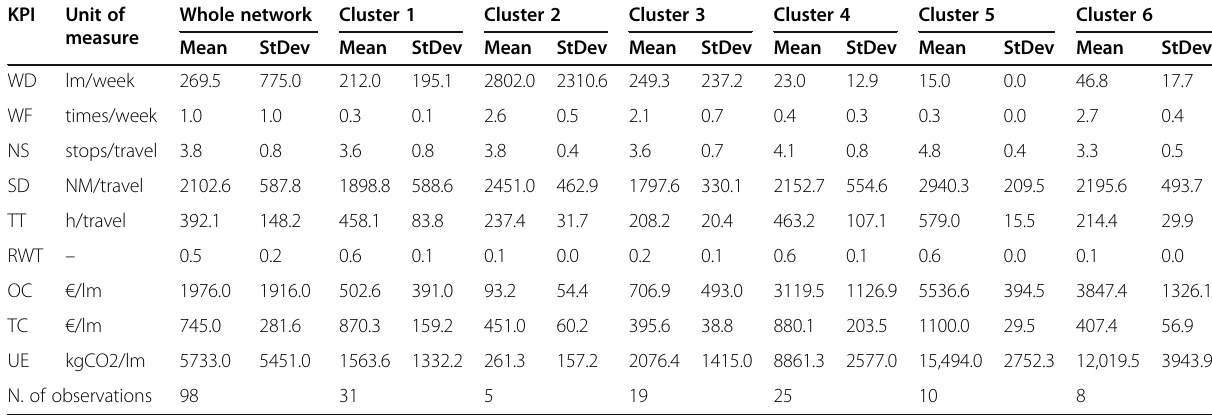
Table 10 Descriptive features of the final partition – Existing network KPI Unit of measure